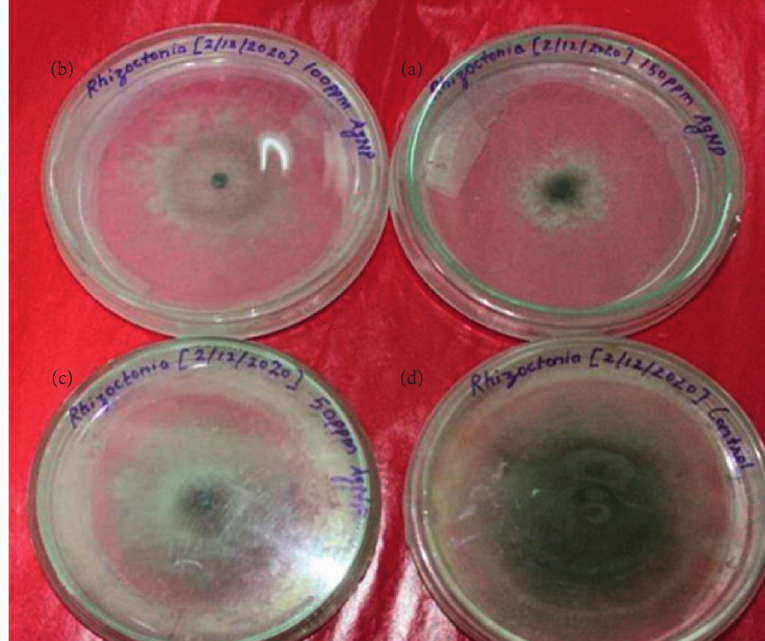
Figure 7: Antifungal bioassay of AgNPs against Rhizoctonia solani by the poisoned food technique. (a) 150ppm. (b) 100ppm. (c) 50ppm. (d) Control. The observation was recorded after 7 days of